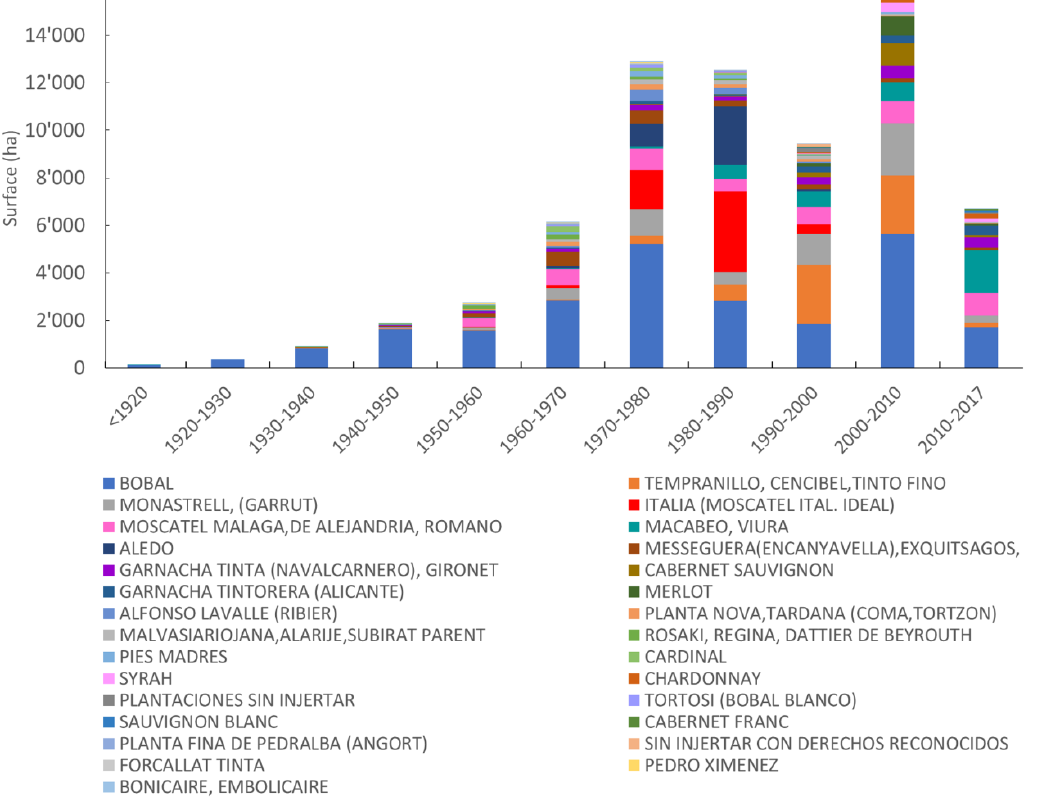
Figure 6. Type of wine (x-axis) and the relative surface area occupied in the region (y-axis, in hectares).